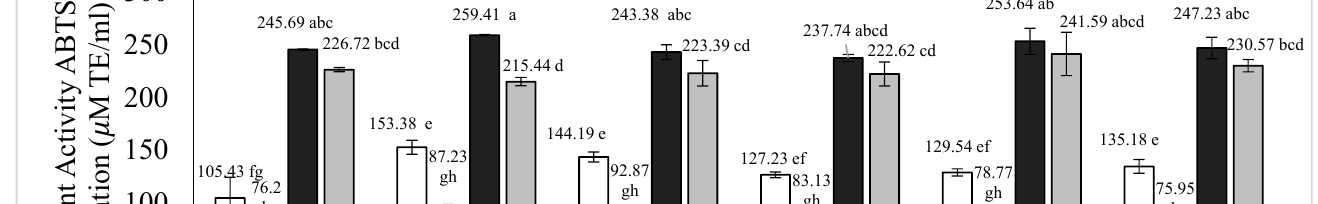
Figure 1. Antioxidant activity (ABTS ˙ method) of requeson cheese with different salt type and concentration treatments, conventional and vacuum packaging. a–h Values with a different superscript indicate significant statistical difference ( p < 0.05).